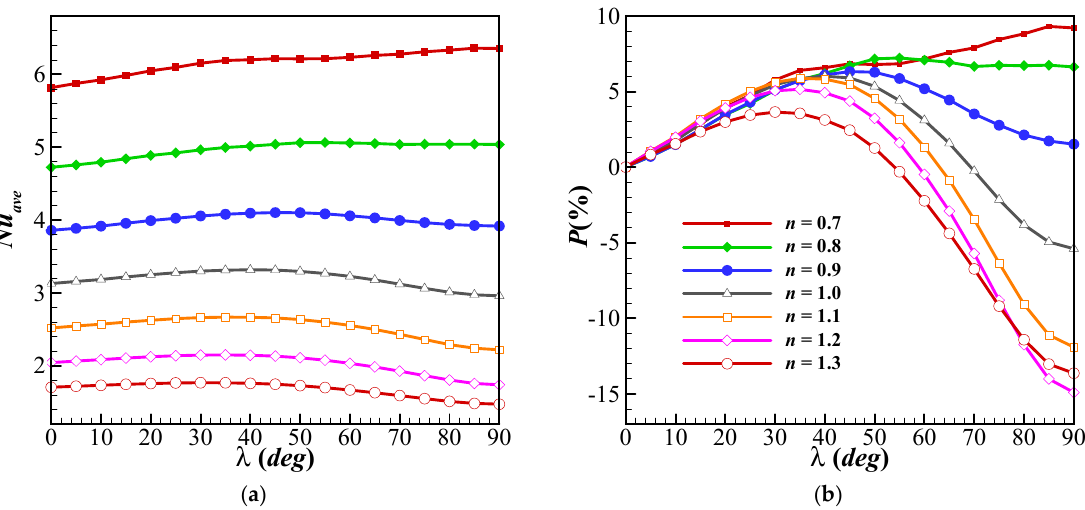
Figure 7. Dependence for different values of power law index, n , on the angle of the location of the centers of the hot and cold arcs of the cavity wall, λ of ( a ) the average Nusselt number in the entire cavity, Nu avg , and ( b ) changes in the average Nusselt number, compared to the base case of λ = 0, when Ra T = 10 4 , Ra M = 10 7 , Pr = 100, Ma = 10 − 4 , β c = 60, δ = 30 ◦ and L =